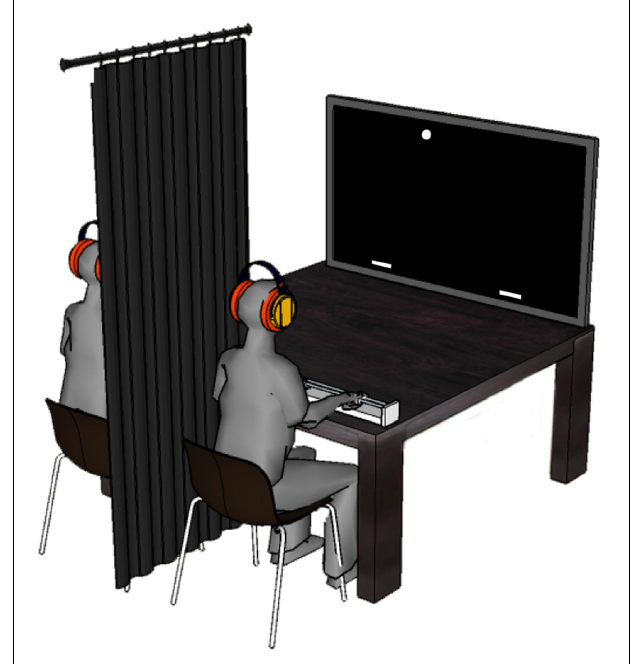
FIGURE 2 | Representation of the experimental setting used in Session 3. Participants were sitting side by side facing a large television screen. They were separated by a black curtain and wore headphones and earplugs so as to avoid overt communication between them. To intercept the balls moving downward across the screen, both participants could move an on-screen paddle along the (non-visible) interception axis by displacing a handheld knob on a linear positioning device placed on the table in front of them. In Sessions 1 and 2 only one of the participants was